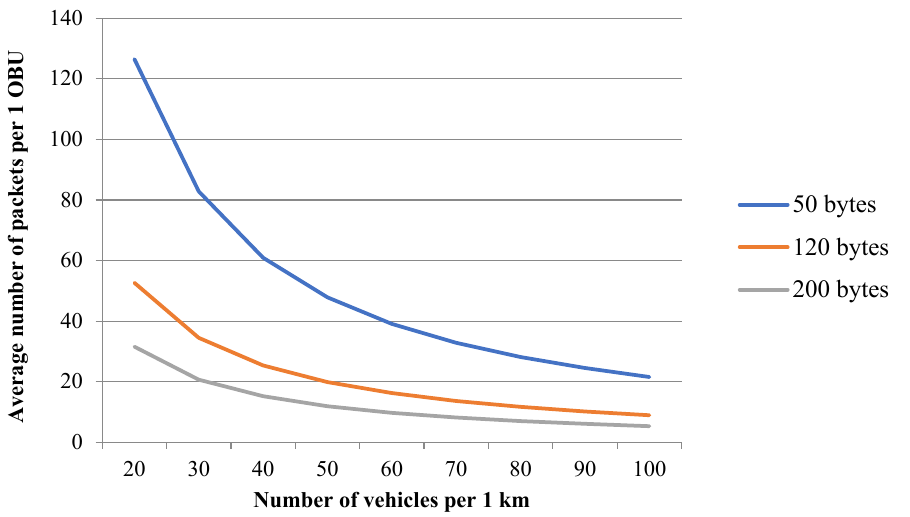
Figure 2. Dependence of the traffic volume available for transmitting information on the number of OBUs per 1 km (1, 2, and 3—confidentiality levels).